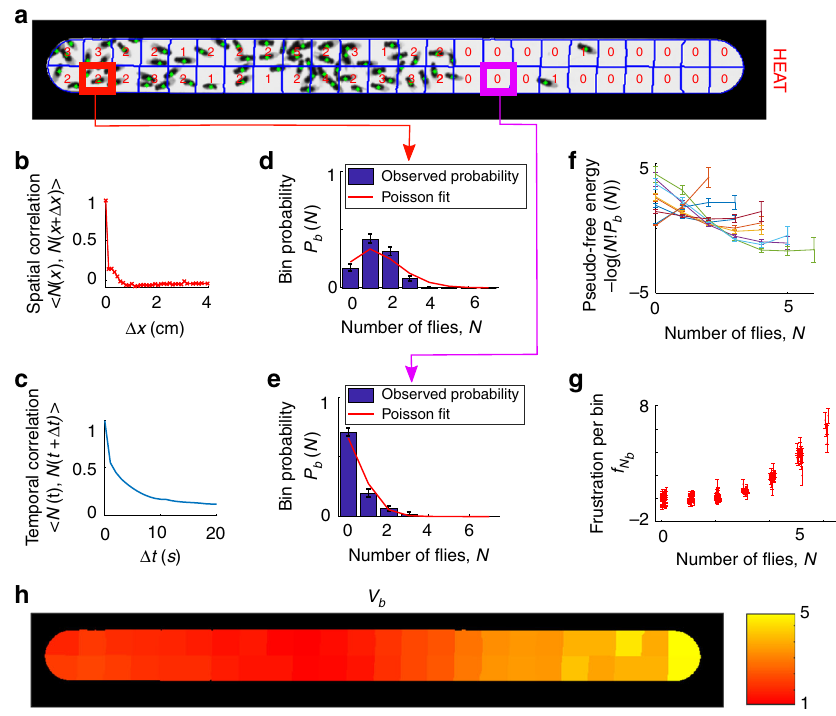
Fig. 2 Statistical analysis and extraction of functionals for walking fruit fl y experiments. a Single frame of 65 fl ies walking in a quasi 1D chamber of dimensions 10 cm × 0.8 cm divided into 48 bins with approximate area 0.15 cm 2 . Heat is applied on the right side of the chamber so that the temperature varies from 35 °C on the left to 50 °C on the right. b Averaged spatial correlation function. c Averaged temporal correlation function. d – e Probability distributions of the number of fl ies in the two bins outlined in a in red and magenta, respectively. f The “ pseudo-free energy, ” − ln( N ! P b ( N )), for eight representative bins. The observed positive curvature indicates deviations from the Poisson form and repulsive interactions. g Frustration functional, f N , obtained from collapse of the pseudo-free energies for all 48 bins upon removal of the Poisson contributions. h Vexation for each bin as measured from the Poisson contributions to the pseudo-free energies. S.d. error bars in d – f computed from Bayesian posterior distribution assuming a Dirichlet prior. S.d. errors bars in g computed from linear propagation of errors displayed in